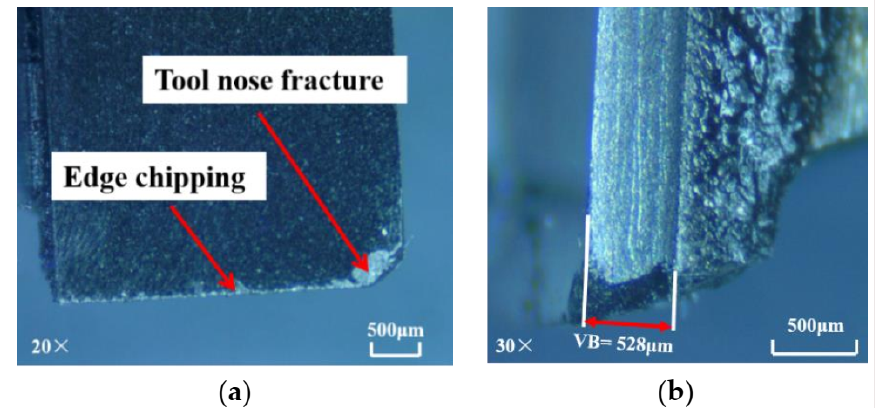
Figure 6. Wear of PCD tool in dry machining: ( a ) rake face; ( b ) flank face (material removal amount = 147 mm 3 ).